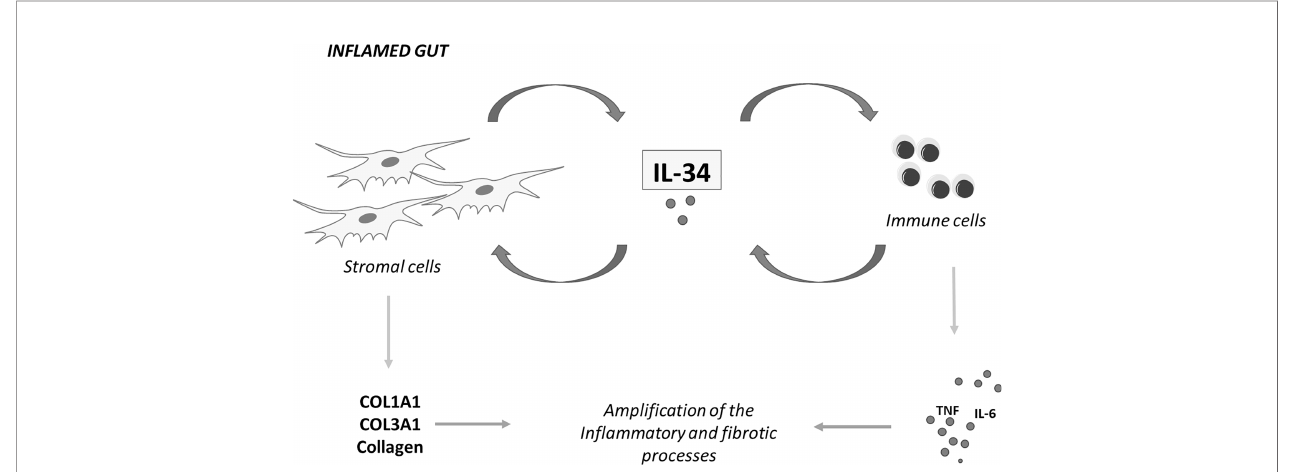
FIGURE 2 | IL-34 mediates cross-talk between stromal cells and immune cells in in fl ammatory bowel diseases. IL-34 produced by intestinal stromal cells stimulates immune cells to make in fl ammatory cytokines and regulates, in an autocrine or paracrine manner, production of collagen by stromal cells. Similarly, immune cell- derived IL-34 regulates the function of both stromal cells and immune cells. COL1A1, collagen type I alpha 1 chain; COL3A1, collagen type III alpha 1 chain; TNF, tumor necrosis factor; IL-6, interleukin-6; IL-34,